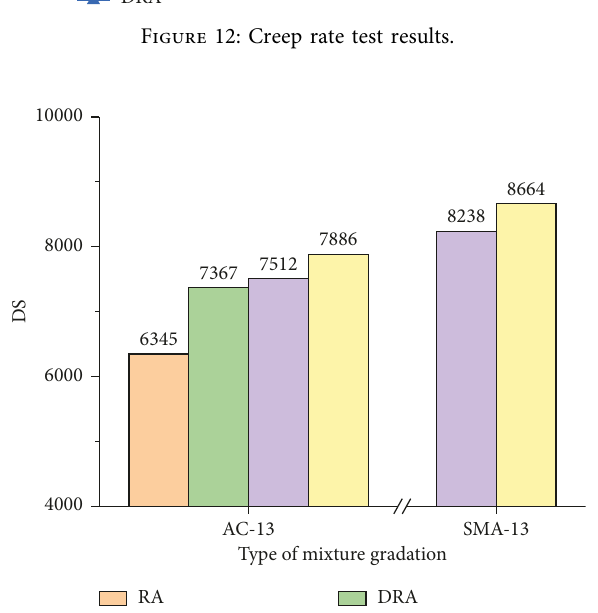
Figure 14: Results of the bending test of